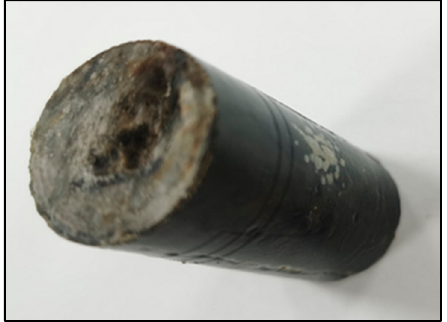
Figure 8. Morphology of the core after dissolution.